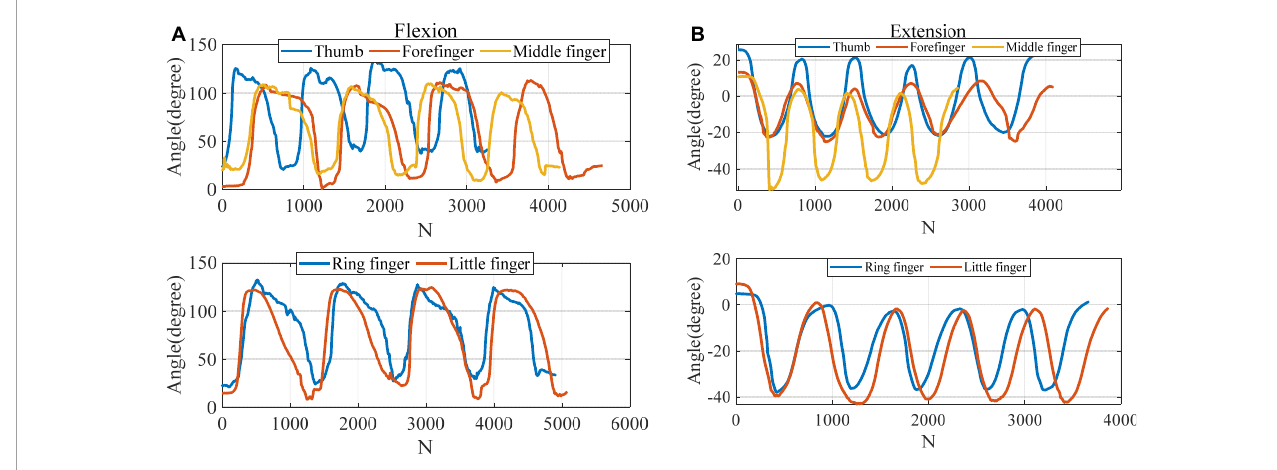
FIGURE11 The motion angles of five fingers. (A) Flexion, (B) extension. N ( N = 62) is the number of samples.